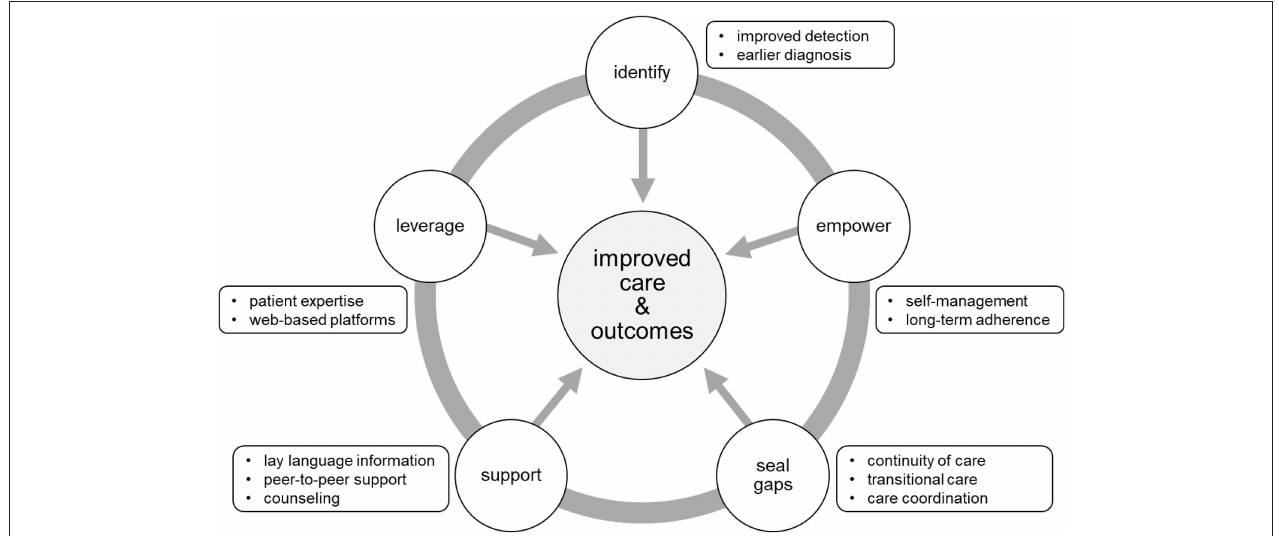
FIGURE 2 | Targets for improving care and outcomes. Five main targets were identified from the literature and feedback from the patient community. Opportunities to improve care and outcomes include: (1) better detection and earlier diagnosis, (2) activating and empowering patients for enhanced chronic disease self-management, (3) promoting continuity of care through care coordination and structured transition from pediatric to adult-oriented care, (4) providing information, enhanced mental health services and access to peer-to-peer support, (5) leveraging technology to extend the reach of care to geographically dispersed